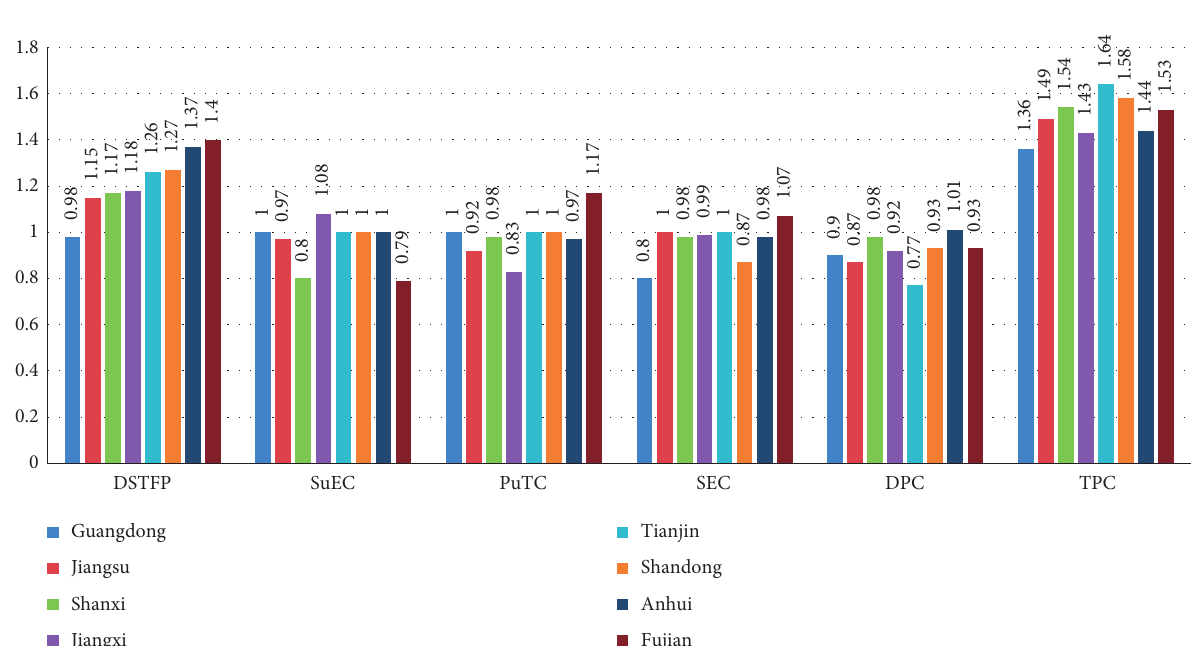
Figure 5: Decomposed efficiency indexes of